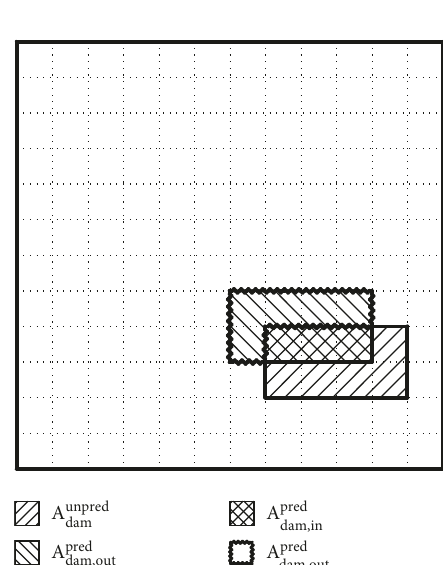
Figure 2: Damage index chart.